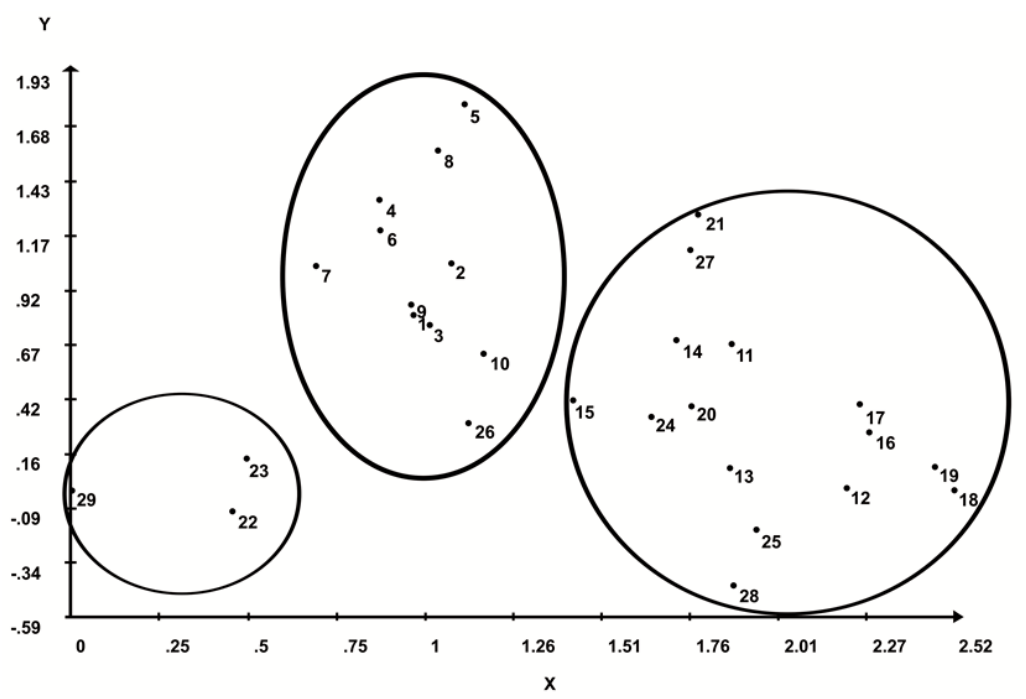
Figure 2. Projection of distances in 2D by taking into consideration the 30 buriti ( M. flexuosa ) individuals, based on the standardized Euclidean distance estimated from 14 quantitative traits of buriti fruits and seeds.